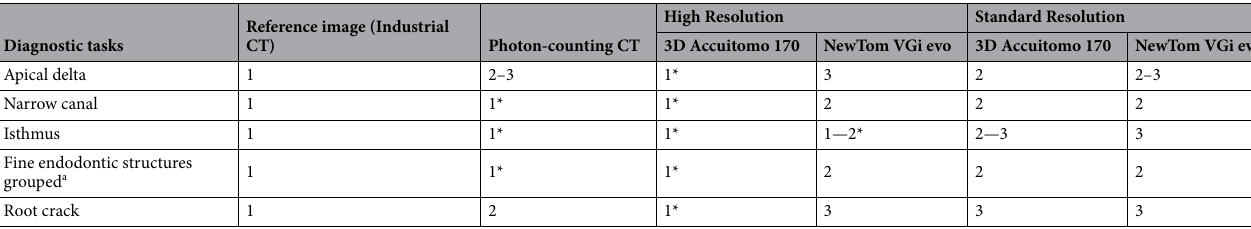
Table 3. Mode values for visualization assessment of fine endodontic structures (apical delta, narrow canal, and isthmus) and root cracks. *Indicates statistical similarity with the reference industrial CT device, which is shown as the reference image (1 – appropriate for visualizing the investigated diagnostic task, 2 – acceptable for visualizing the investigated diagnostic task, and 3 – inappropriate for visualizing the investigated diagnostic task). a Indicates the fine endodontic structures (apical delta, narrow canal, and isthmus) grouped.